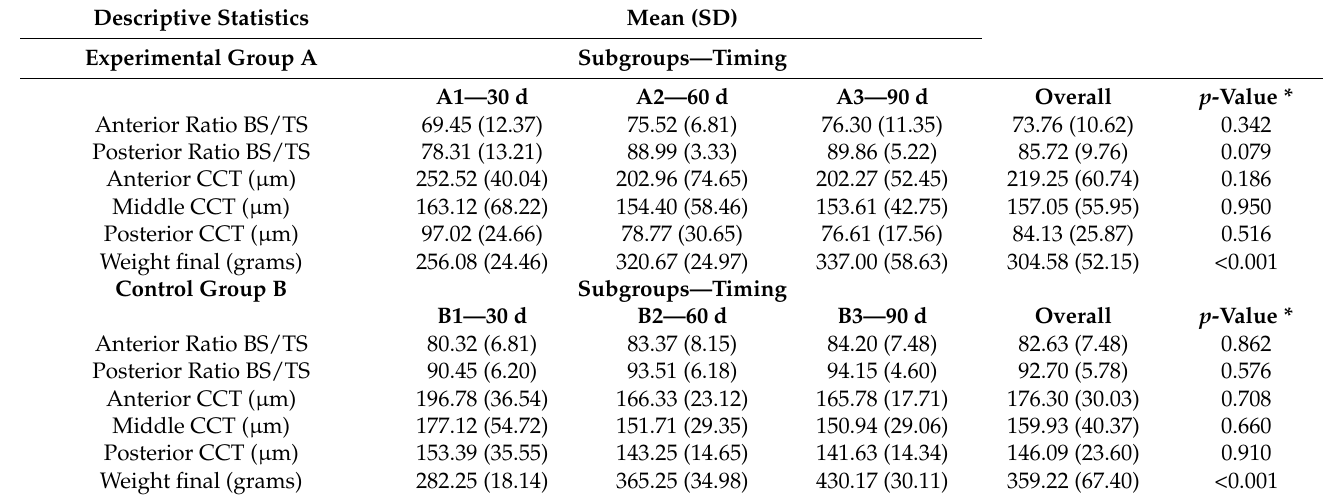
Table 5. Descriptive statistics (mean and standard deviation) for each measurement by timing and overall for Groups A and B.